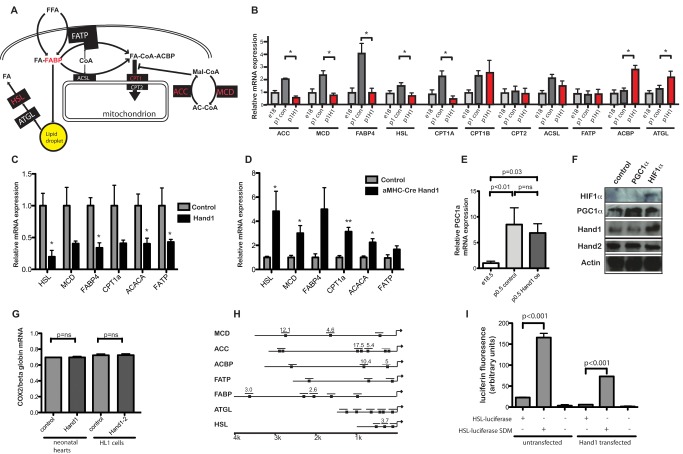
Prolongation of neonatal cardiac Hand1 expression prevents transcriptional up-regulation of lipid metabolizing genes.(A) Schematic showing myocardial lipid metabolism (adapted from Kodde et al. [55]). (B) RTPCR showing RNA expression in e16 control, p0.5 control, and p0.5 hand1 up-regulating hearts. Levels of ACC, MCD, FABP4, ACSL, CPT1A CPT1B, and HSL are significantly up-regulated around birth (p<0.05 two-tailed t test, n = 4 each group). No postnatal rise in ACC, MCD, FABP4, CPT1A, and HSL is seen in Hand1 up-regulating hearts. Significantly increased RNA expression of ACBP and ATGL is seen in Hand1 up-regulating hearts. Genes whose expression is reduced in Hand1 overexpressing hearts are in red in (A). ACC, acetyl coA carboxylase; MCD, malonyl coA decarboxylase; FABP, fatty acid binding protein; FATP, fatty acid transport protein; ACSL, acyl coA synthase long chain 1; HSL, hormone sensitive lipase; ATGL, adipose triglyceride lipase; ACBP, acylcoA binding protein; CPT, Carnitine Palmitoyl Transferase. (C) RTPCR of mRNA from 2-mo-old adult XMLC2-Hand1 mice following doxycycline induction for 2 wk, showing changes in expression of RNA encoding fatty acid metabolising proteins relative to control non-up-regulating mice (*p<0.05, **p<0.005, two-tailed t test, n = 4 each group). (D) RTPCR of mRNA from e14.5 embryo hearts from αMHC-Cre::Hand1(fl/fl) and control pups, showing up-regulation of genes encoding fatty acid metabolising enzymes(*p<0.05, two-tailed t test, n = 4 each group). (E) RTPCR showing significant PGC1-α elevation in the heart around birth (n = 4 each group, p = 0.008, two-tailed t test), with no significant drop in Hand1 up-regulating hearts (p = 0.26, n = 6 each group). (F) Western blot of protein extract from cultured HL1 cardiomyocytes nontransfected (“control”) and transfected with PGC1-α and HIF1, showing no elevation of Hand1 in PGC1-α elevated PGC1α and Hand1 but not Hand2 protein expression in HIF1 expressing cells. (G) PCR of nuclear genomic (globin) and mitochondrial (COX2) DNA showing unchanged ratio in Hand1 elevating neonatal hearts and Hand1-transfected HL1 cells compared with controls, implying no change in mitochondrial number. Control HL1 cells are transfected with an empty vector. (H) Map of 5′ promoters of several putative Hand1 transcriptional targets in the e18.5 heart. Numbers refer to fold enrichment over γ crystallin in chromatin immunoprecipitation assay using anti-Hand1 serum. For more detailed chromatin immunoprecipitation data, please see Text S1 and Figure S2. (I) Site-directed mutagenesis of the Hand1-binding canonical CANNTG e-box in the 5′ HSL luciferase promoter de-represses expression of luciferase in HL1 cells, both in untransfected cells and cells stably expressing Hand1 (transfections in triplicate, measurement in quadruplicate, p values, two-tailed t test).